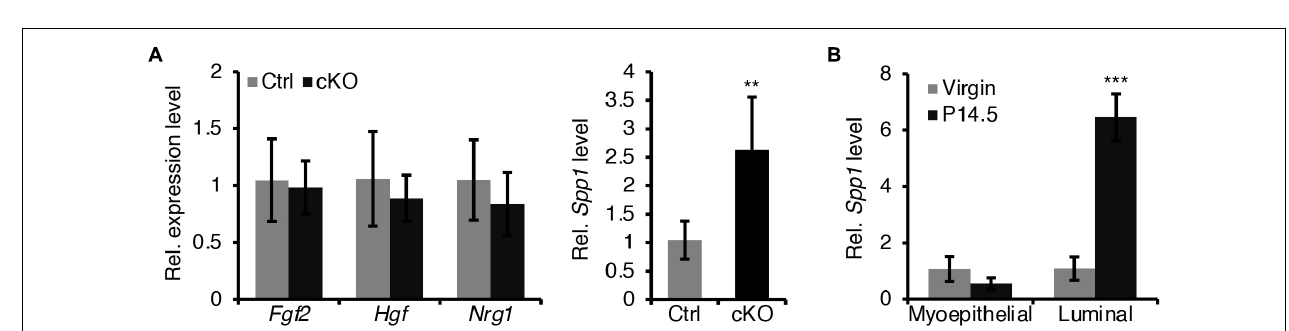
FIGURE 7 | Loss of BMPR1a in myoepithelium resulted in an upregulation of Spp1. (A) qRT-PCR analysis of Fgf2 , Hgf , Nrg1, and Spp1 in sorted mammary myoepithelial cells from control and cKO mice at pregnancy day 14.5. n ≥ 4 biological replicates. (B) qRT-PCR analysis of Spp1 in sorted myoepithelial and luminal